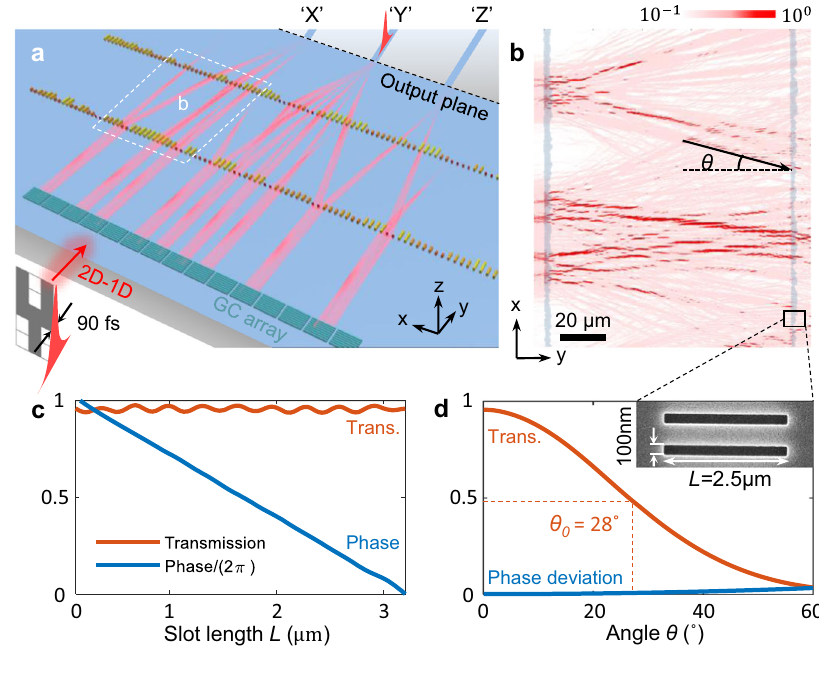
Fig. 1 Integrated metasurface system for spatial pattern classi fi cation. a Schematics of the system architecture. As an example, a pattern ‘ Y ’ with less than 90 femtosecond pulse duration is coupled to the integrated metasystem through the input grating coupler array (green gratings). Through the diffractions through the metasystem, the light is converged onto the position on the output plan where the correspondent waveguide channel locates. b Subwavelength structure manifested diffraction between metasurface layers. The numerically simulated light intensity is superimposed onto the optical microscope image of a fabricated metasystem. c Amplitude and phase of the complex transmission coef fi cient versus the slot length L (indicated in the inset of d ) with the fi xed slot width of 100 nm. d Amplitude and phase of the complex transmission coef fi cient versus the incident angle ( θ indicated in b ) with the slot width of 100 nm and L of 2.5 μ m. Inset: Scanning electron microscope (SEM) image for the zoom-in view of the metasurface cell in b